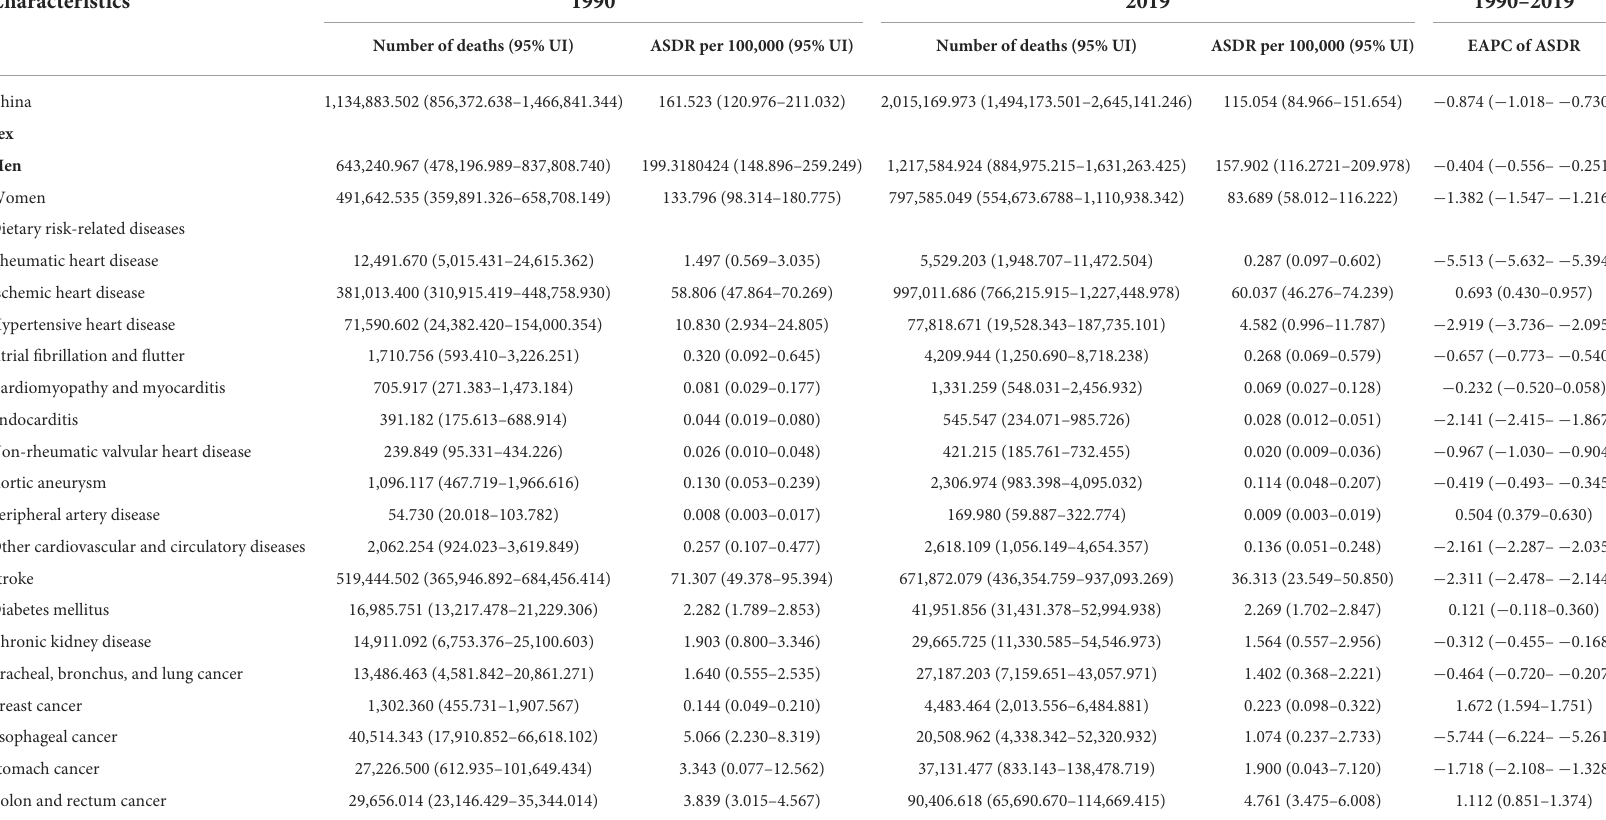
TABLE 1 The death numbers and age-standardized death rates of dietary risks in